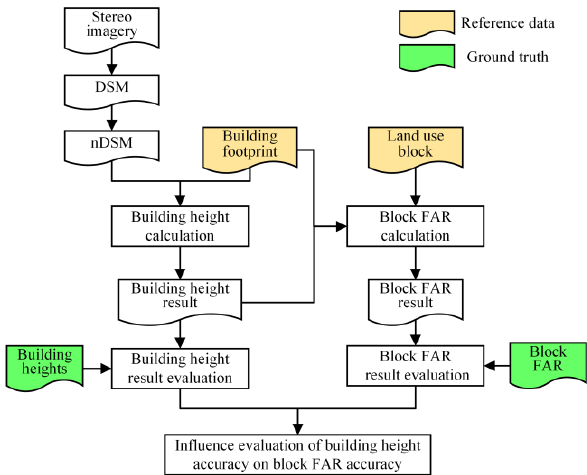
Figure 1. A flowchart of our method to investigate the influence of building heights on block FAR